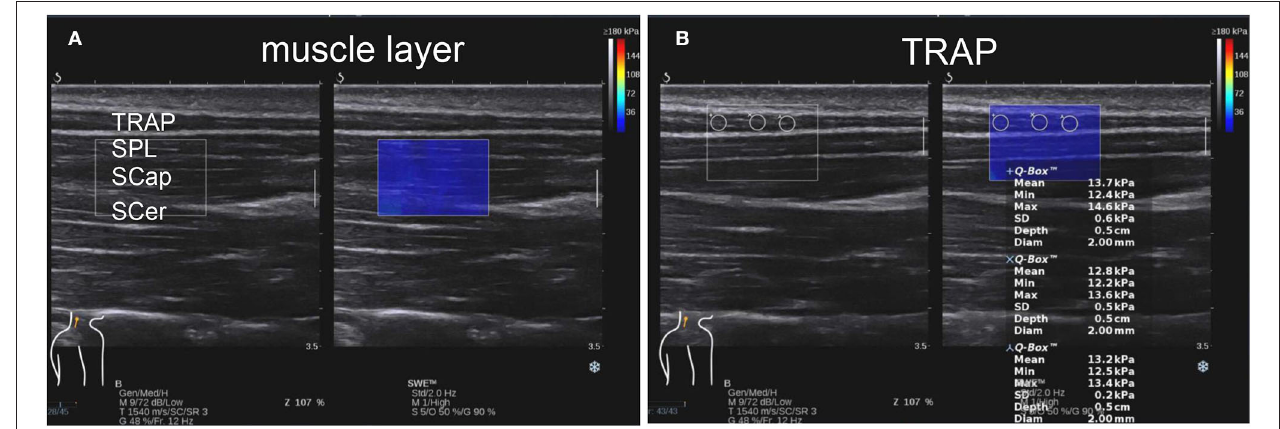
FIGURE 1 | In the shear wave elastography (SWE) mode, image (A) showing muscle stratification of TRAP, splenius capitis (SPL), semispinalis capitis (SCap), and semispinalis cervicis (SCer) on the left, while the dark blue area on the right is the elastic sampling frame. Image (B) shows representative elastic diagrams of TRAP of the cervicogenic headache (CEH) group. The shear elastic modulus of region of interest (ROIs; the three white circles) in the elastic sampling frame is calculated. Three ROI values of TRAP are 13.7, 12.8, and 13.2 kpa. TRAP,